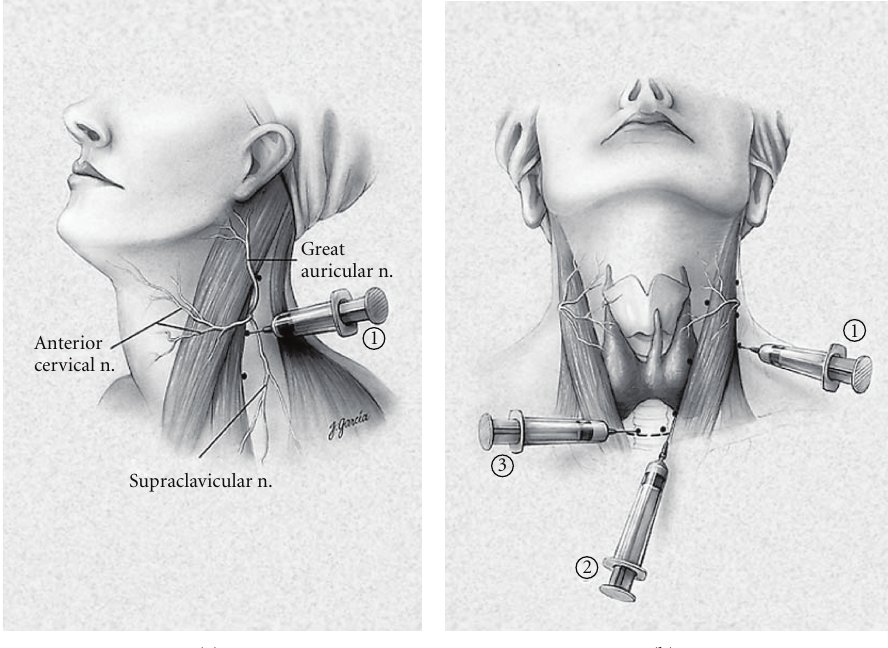
Figure 2: Cervical block anesthesia. (a) A superficial cervical block is administered posterior and deep to the sternocleidomastoid muscle (SCM; 1). (b) Local infiltration is also performed along the anterior border of the SCM [2], followed by a local field block [3]. (From [34], with permission, Copyright 2002, Lippincott Williams &Wilkins).